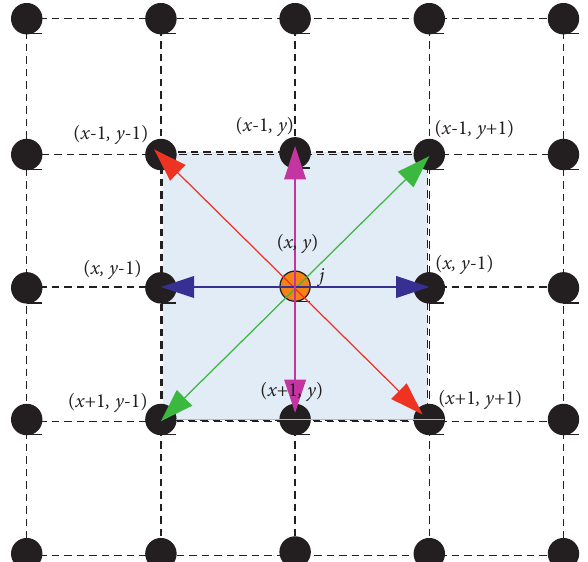
Figure 3: The relative position among the pixel j .